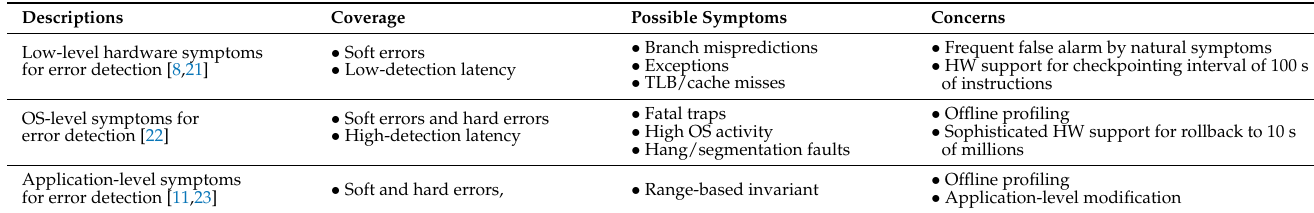
Table 1. Overview of existing symptom-based